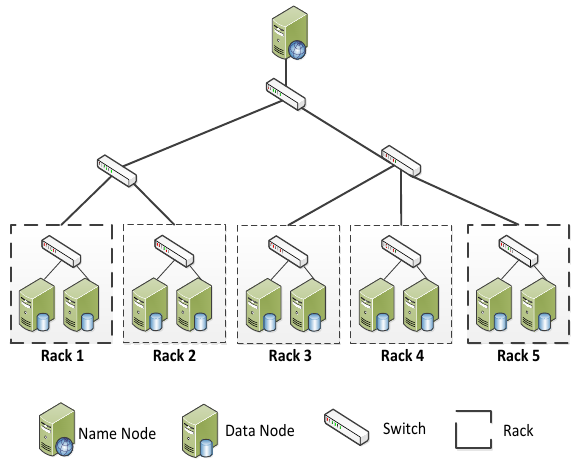
Fig. 4. The structure of HDFS.